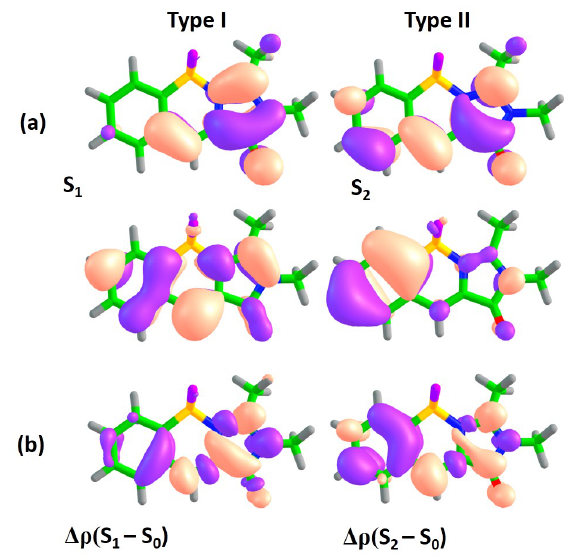
Figure 2. XMCQDPT2 natural orbitals actively involved in the S 0 –S 1 and S 0 –S 2 transitions ( a ) and the corresponding differential electron densities ∆ ρ ( b ) for compound 1 . For each state, the excitation is directed from the lower orbital to the higher orbital. The color code stands for negative and positive ∆ ρ values depicted in blue and red,